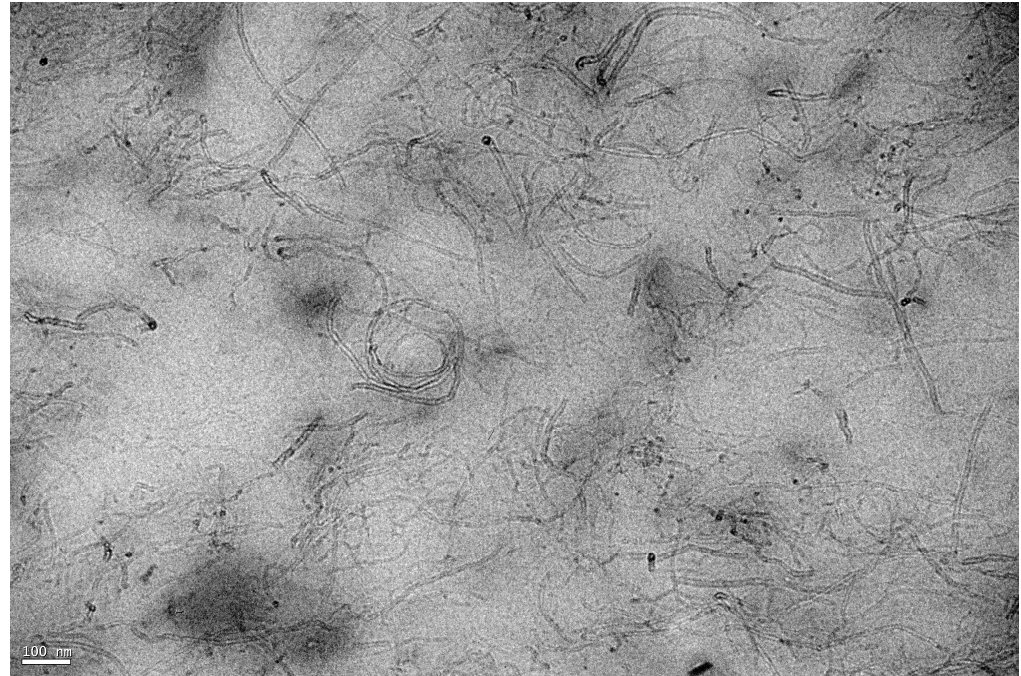
Figure 10. TEM image of NR filled with 3 phr of MWCNTs. The scale bar represents 100 nm.